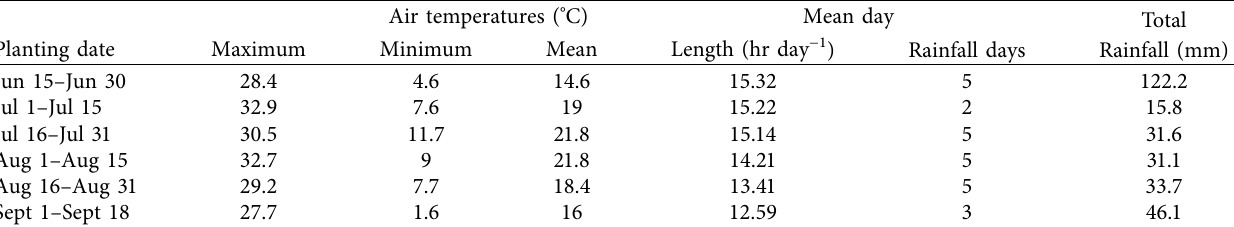
Table 2: Mean air temperature, day length, number of rainfall days, and rainfall amount throughout the planting season in summer 2018